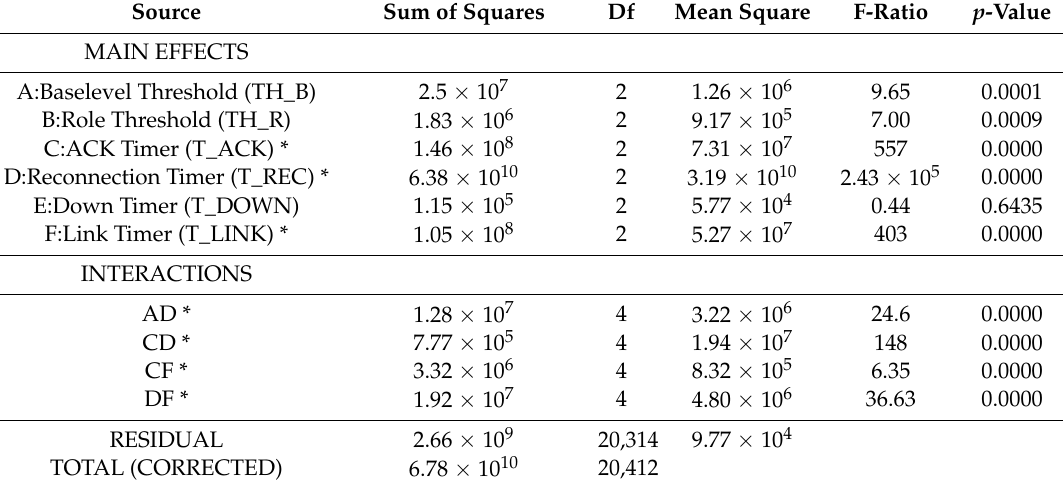
Table 9. Summary of the ANOVA table, which decomposes the variability Convergence Time (s) into contributions due to several factors. The factors and interactions marked with * are statistically significant.